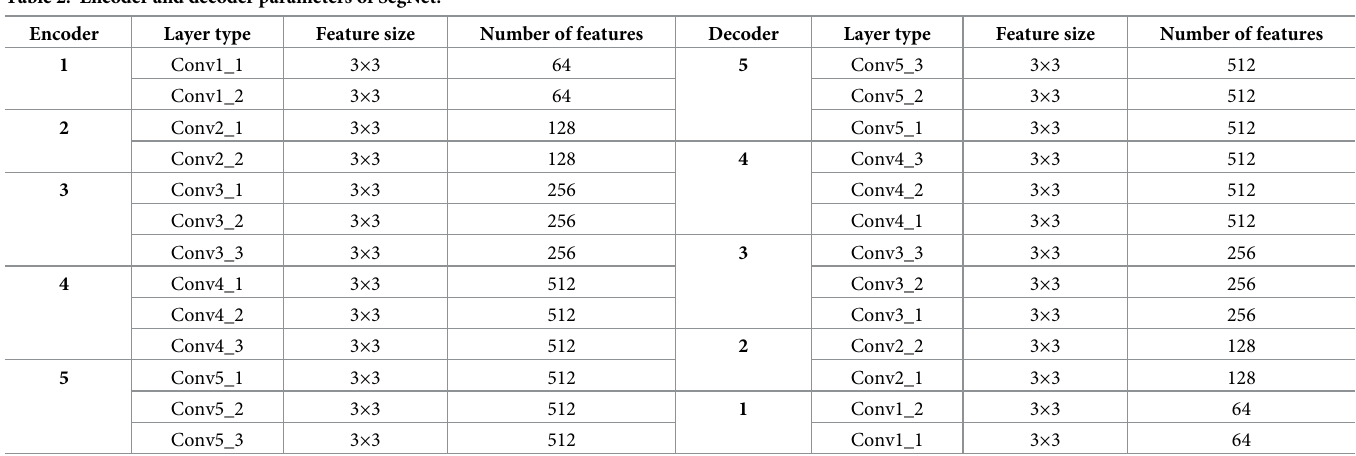
Table 2. Encoder and decoder parameters of SegNet.